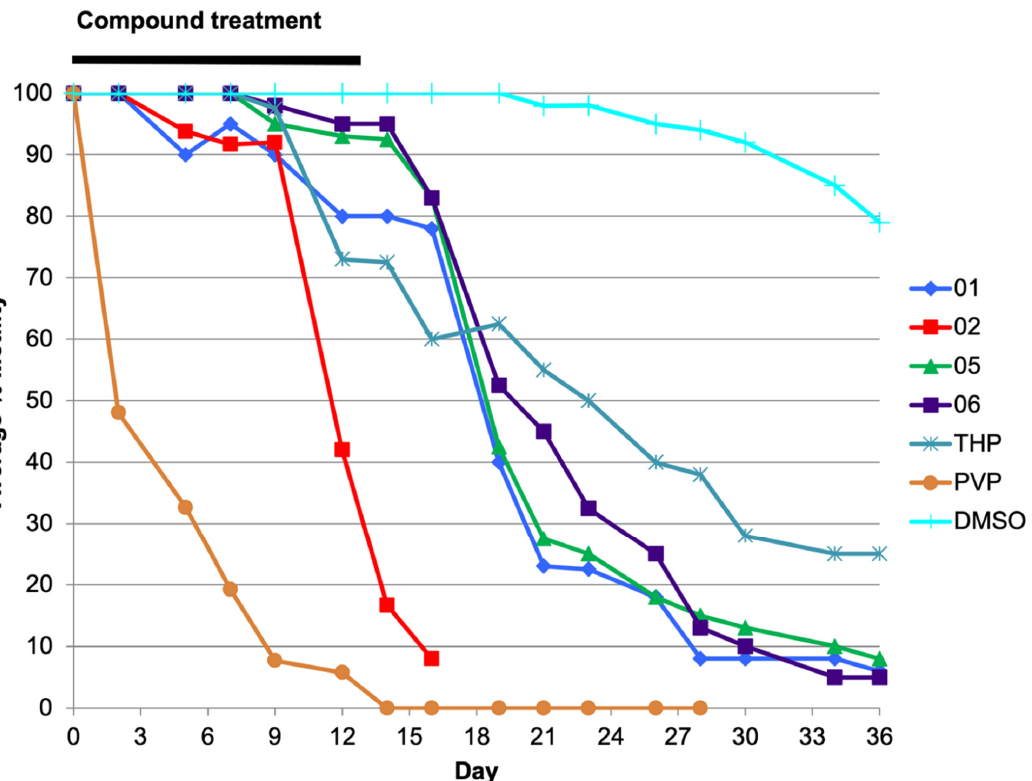
Figure 2. Ov L5 were treated with 1 µM of 01, 02, 05, 06, THP and PVP for 14 days (change of media + drug 50% every two days) and then with fresh media (change of media 50% up to day 36). PVP treated L5 worms did not recover during this washout period and the assay with analog 02 was stopped on day 16 when contamination was observed. Inhibition of motility was well correlated with inhibition of viability as measured by endpoint MTT assay (Supporting Information Table S1). 2 . 2. Ov L5 Treated with 10 µM THP In Vitro Show Ultrastructural Damage Ov L5 worms treated with THP in vitro were assessed by transmission electron mi- croscopy (TEM) to examine the qualitative effects of drug treatment on the ultrastructural integrity of the worms. The Ov L5 were cultured in vitro to day 78 and then treated for 14 days with 10 µM THP, exchanging the media with compound every other day. After the 14 days of treatment, the Ov L5 were kept in fresh media for the next 7 days, with media exchanged every other day. THP treatment caused significant damage as evidenced by the significant vacuolization and necrosis (Figure 3) occurring in worms treated with THP.